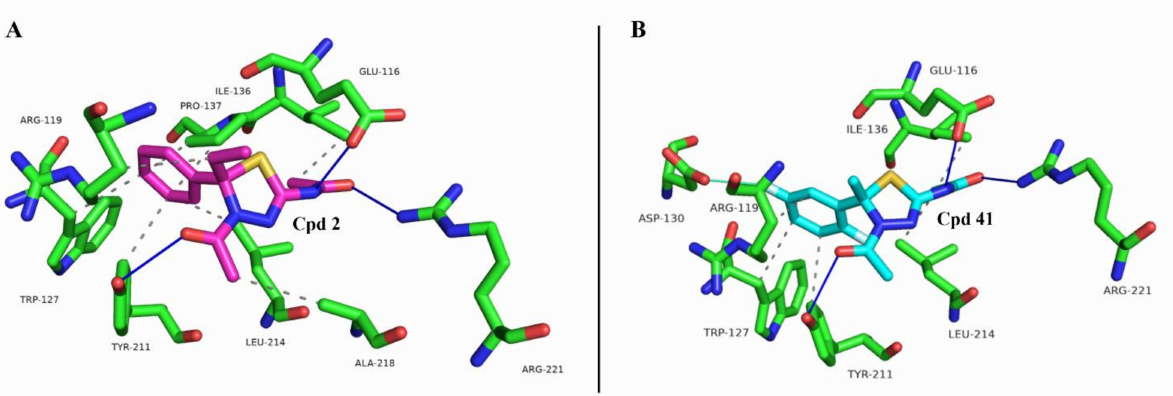
Figure 3. Docking pose of compounds 2 ( A ) and 41 ( B ) with Eg5. Interacting-residues are represented by green sticks and labelled. Compounds 2 and 41 are presented in purple and cyan sticks, respec- tively. Hydrogen bondings and hydrophobic contacts are shown in solid blue and dotted grey lines, respectively. Halogen bonding is reported through a solid cyan line. The figure was prepared through Protein-Ligand Interaction Profiler (PLIP) web service [34] and the PyMOL Molecular Graphics System, Version 2.5 Schrödinger, LLC